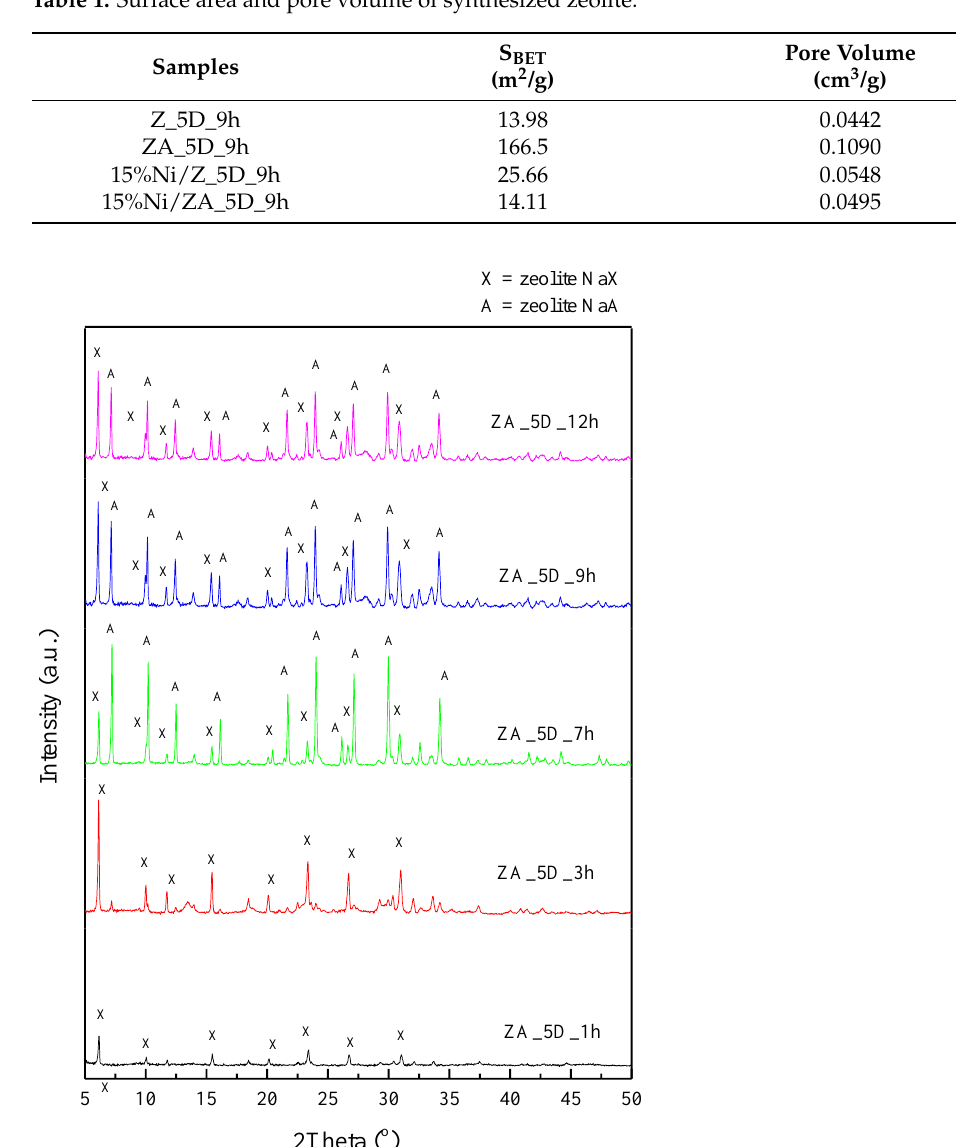
Table 1. Surface area and pore volume of synthesized zeolite.